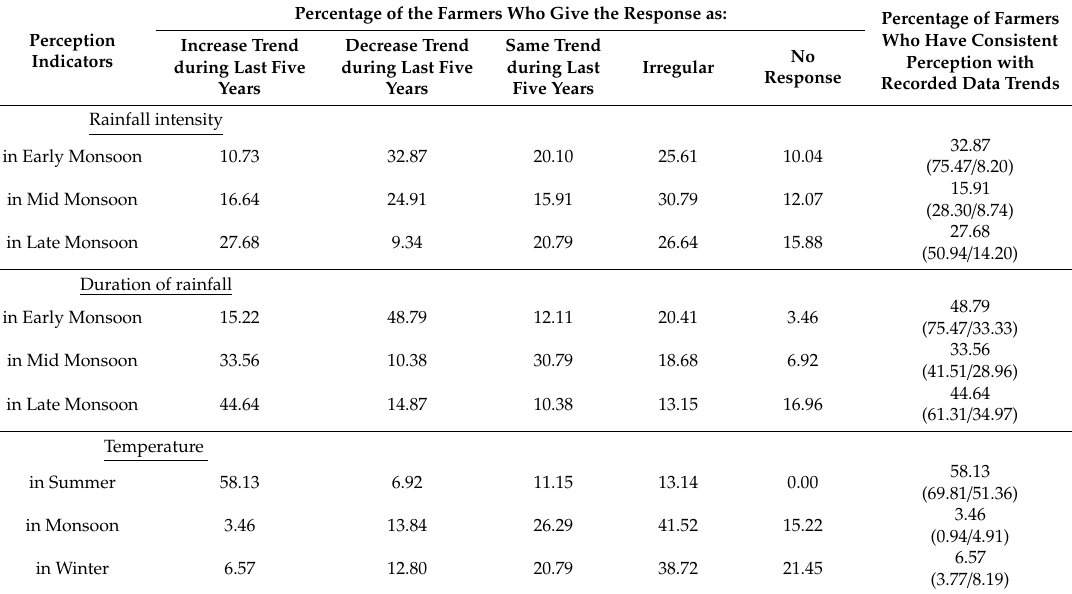
Table 4. Accuracy of farmer’s perception by meteorological data analysis. Perception